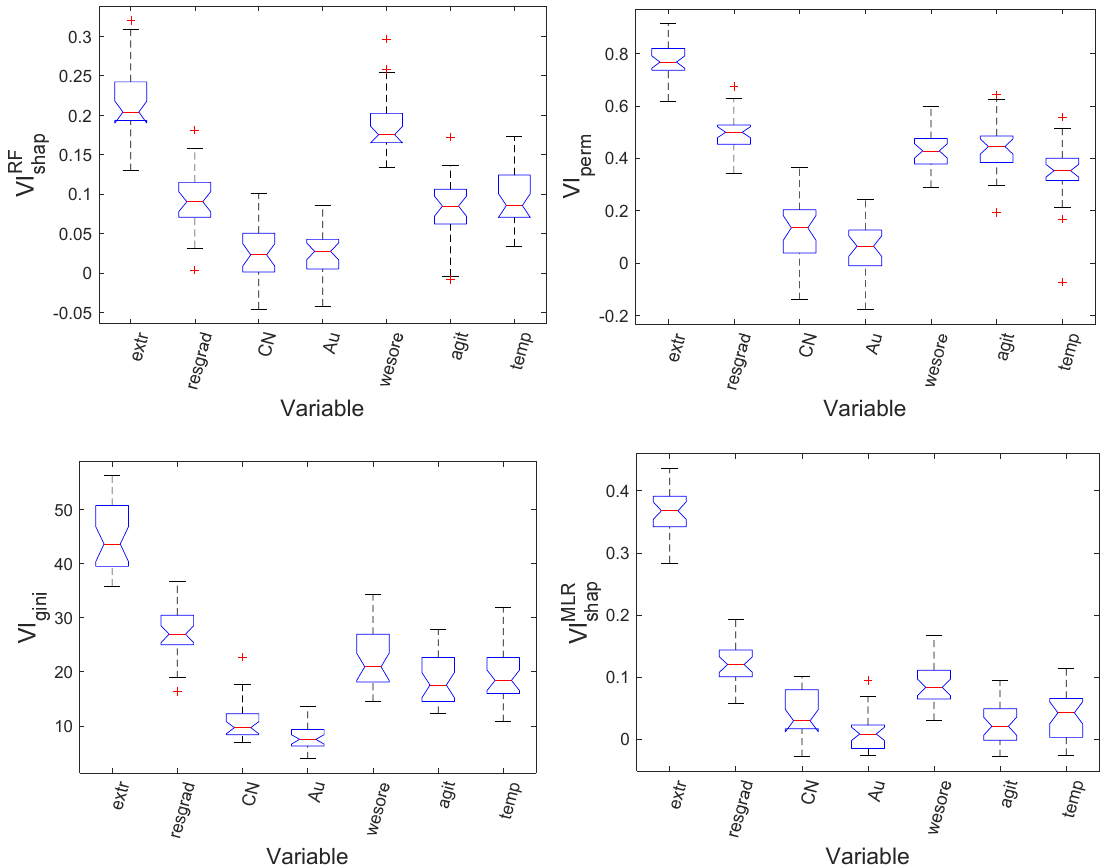
Figure 13. Variable importance analysis with the Shapley regression forest ( top , left ), permutation random forest ( top , right ), Gini random forest ( bottom , left ), and Shapley linear regression ( bottom , right ), based on 30 runs.